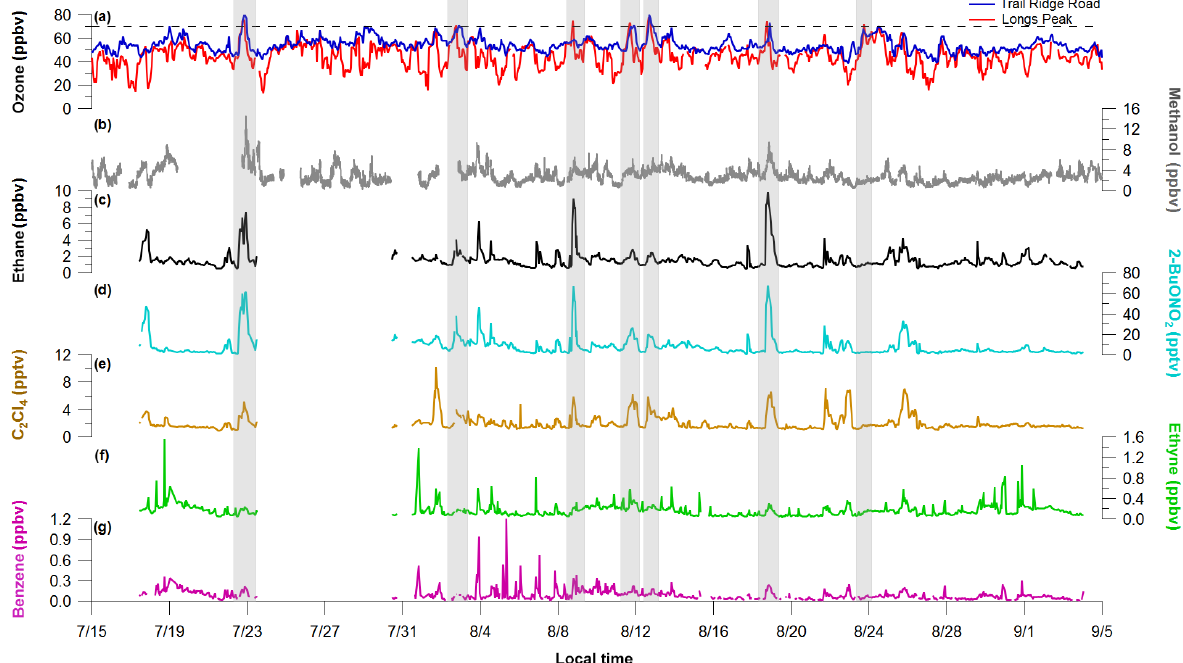
Figure 3. A subset of VOCs measured at the ROMO-LP site from 17 July to 4 September 2014. From 19 to 22 July and from 23 to 30 July, the PTR-MS and GC system, respectively, were shut down due to air conditioner failures in the field laboratories. Ozone measurements from both the ROMO-LP (Longs Peak) and ROMO-TR (Trail Ridge Road) sites are also shown. Shaded areas represent periods selected for further analysis when hourly O 3 exceeded 70ppb (dashed line).